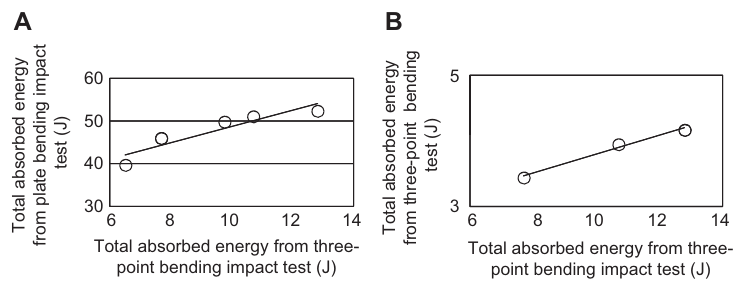
Figure 12 Total absorbed energy (A) from the plate bending impact test and from the three-point bending impact test and (B) from the three-point bending test and from the three-point bending impact